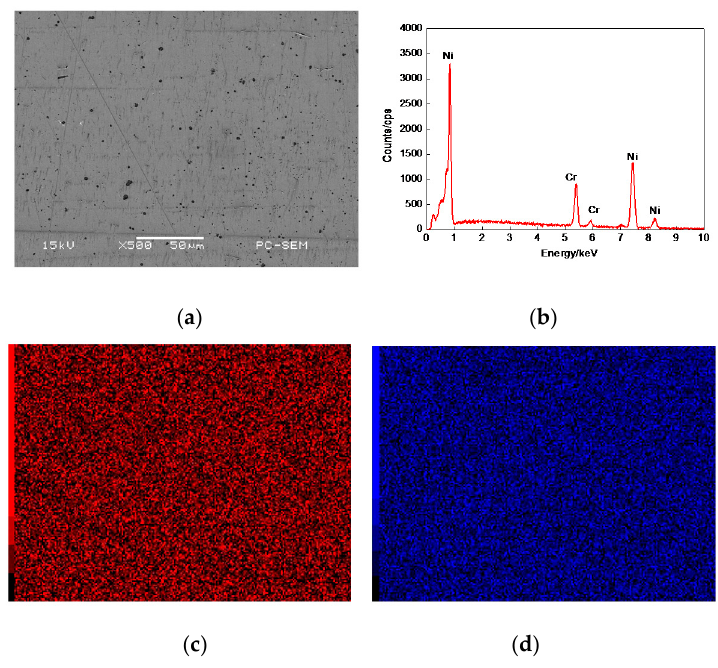
Figure 4. Plane scan analysis of 20% Cr–80% Ni coating surface. ( a ) Plane scanned position; ( b ) Plane